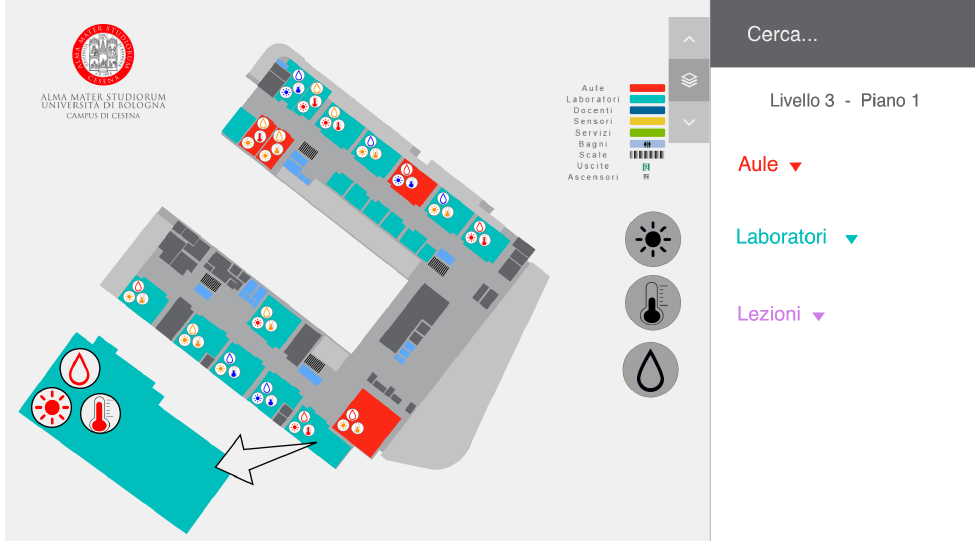
Figure 6. The UI of the first prototype with the three icons on the left selected. The three icons were all selected so each space has inside it the three icons displaying the current value for each sensor, as shown in the zoomed space on the bottom left of the